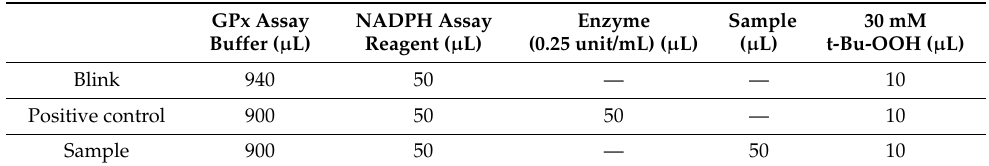
Table 2. Glutathione peroxidase reaction